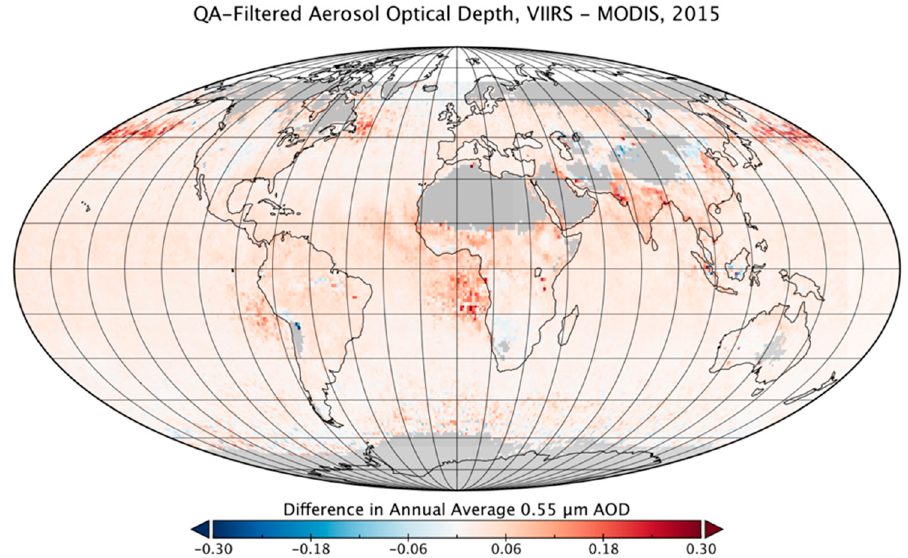
Figure 4. Annual average difference between VIIRS SNPP and MODIS Aqua 0.55 μ m AOD on a one-degree grid for 2015. The mean of all grid cells is +0.03.